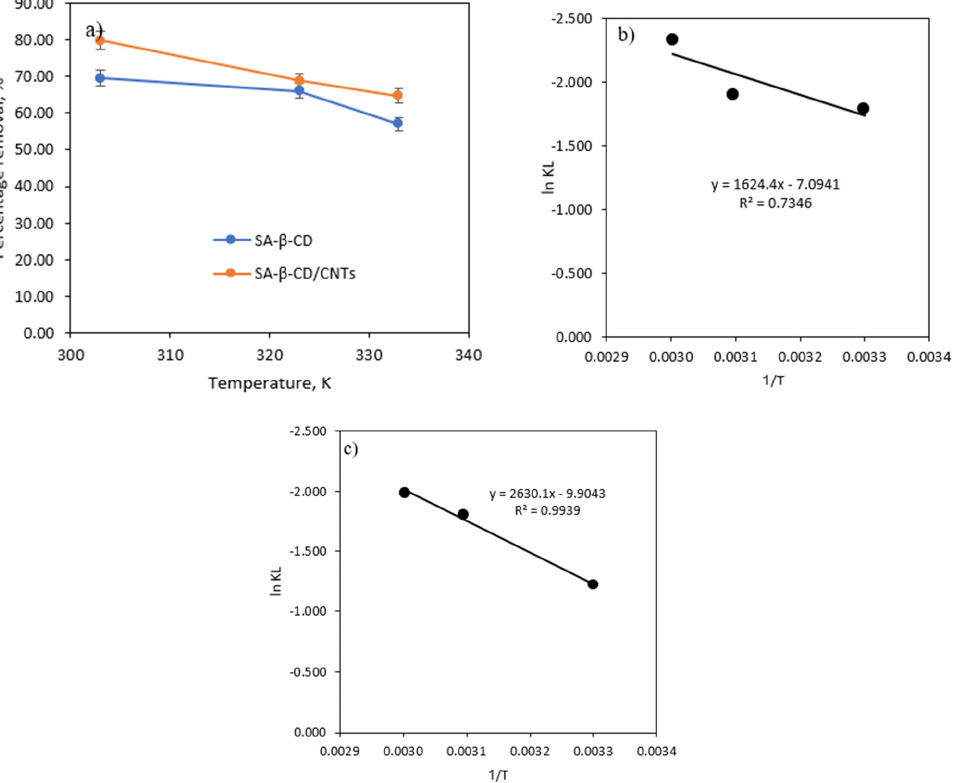
Figure 13. ( a ) Effect of temperature of Ni(II) on SA −β− CD/CNTs hydrogel ( b ) van’t Hoff plot for SA −β− CD ( c ) van’t Hoff plot for SA −β− CD/CNTs.